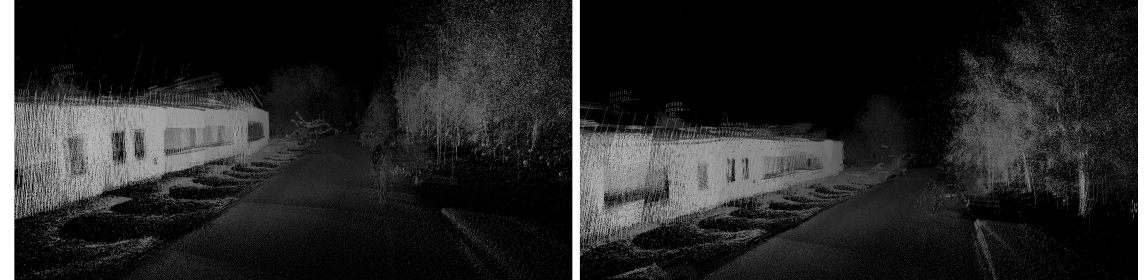
Figure 22. Reducing the rotation error leads to matching walls and a straight road.